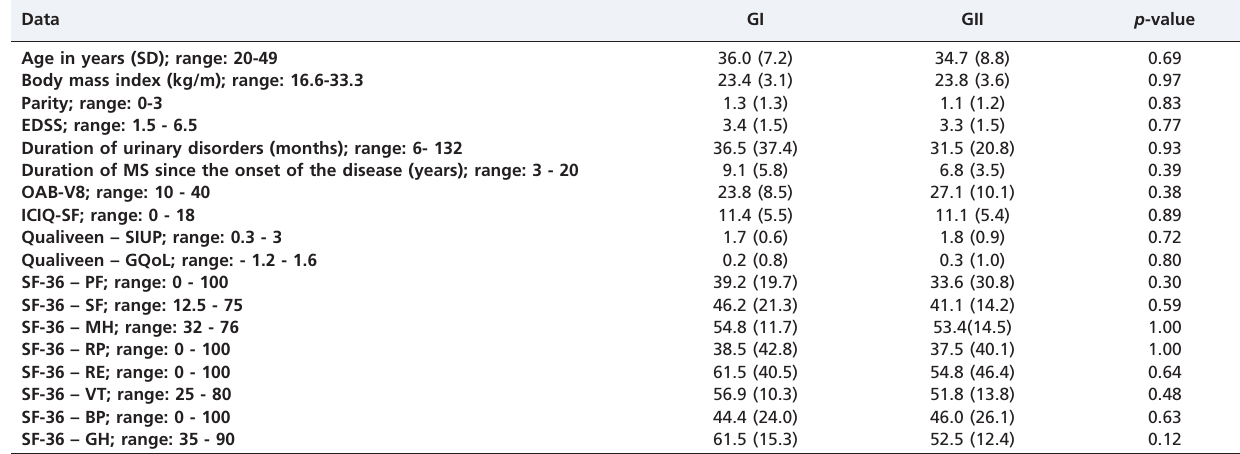
Table 1 - The mean, standard deviation (SD) and p -value of the baseline, demographic data and the initial assessments in the treatment (GI) and sham (GII) groups, as determined by the Mann-Whitney test.